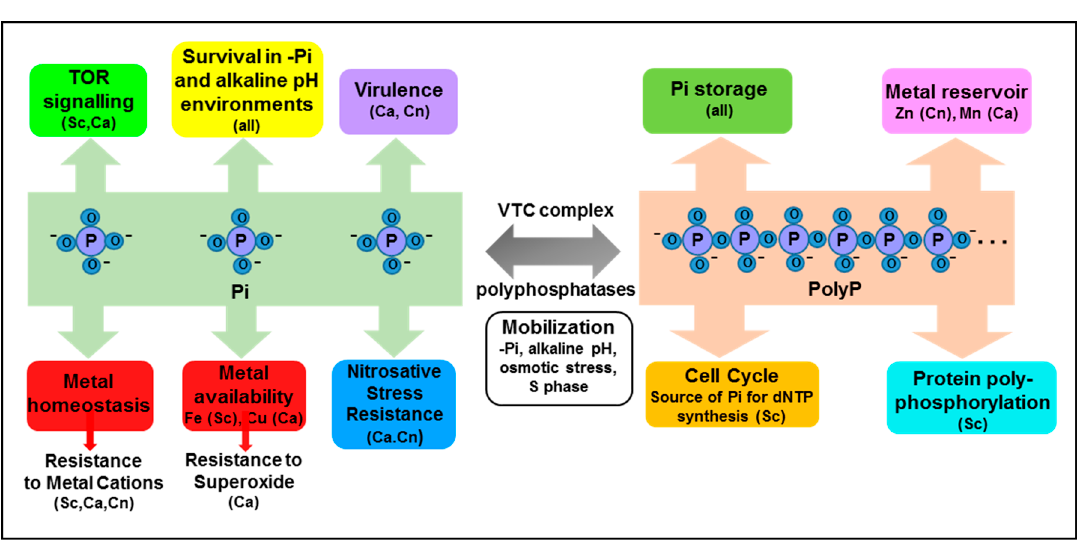
Figure 2. Emerging roles of intracellular Pi and polyP. Phosphate plays well-established roles in many biomolecules and biochemical processes, and is stored in the vacuole as polyP. However additional roles of inorganic phosphate (Pi) and polyP are emerging in fungi, and are summarised above. See text for details. Abbreviations: Sc; S. cerevisiae , Ca; C. albicans , Cn; C.